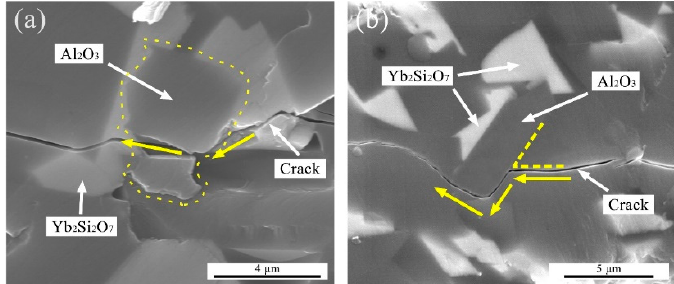
Figure 5. SEM micrographs of different crack penetration modes: ( a ) trans-granular fracture and ( b ) crack deflection.